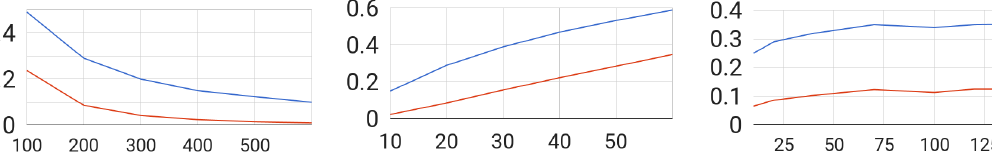
Figure 6. The ratio between the size (vertices in blue, edges in red) of the concrete and truncated V W networks as , k , and | | | |